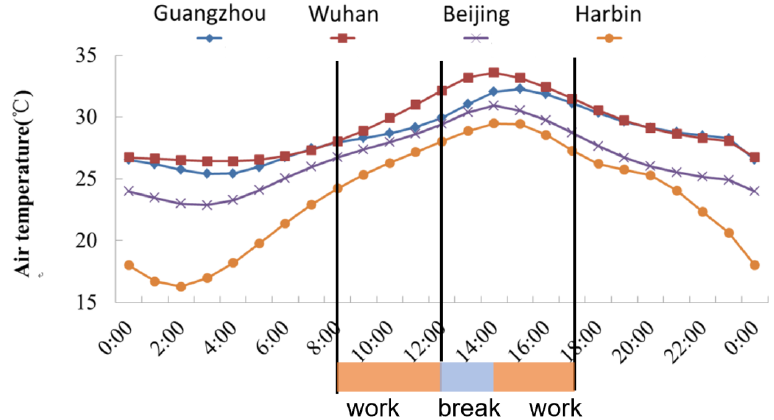
Figure 7. Air temperature on 21 June.